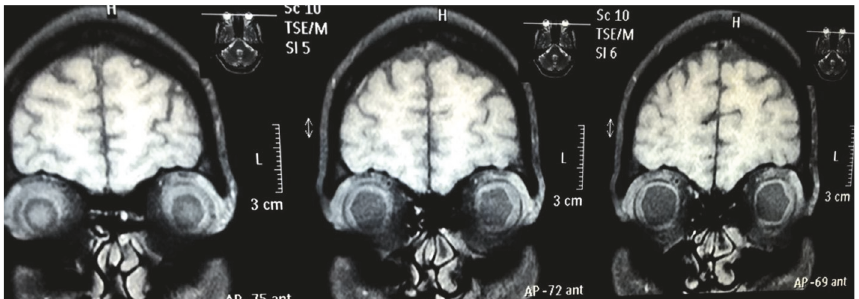
Figure 2: Coronal T1 weighted MRI of head and orbit showing bilateral choroidal detachment with bilateral suprachoroidal haemorrhage.